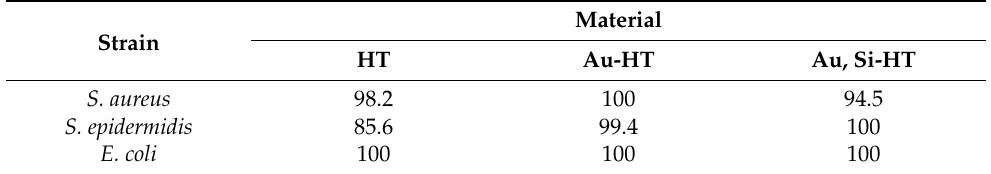
Table 4. Percentage reduction of bacterial viability after incubation for 24 h with the tested